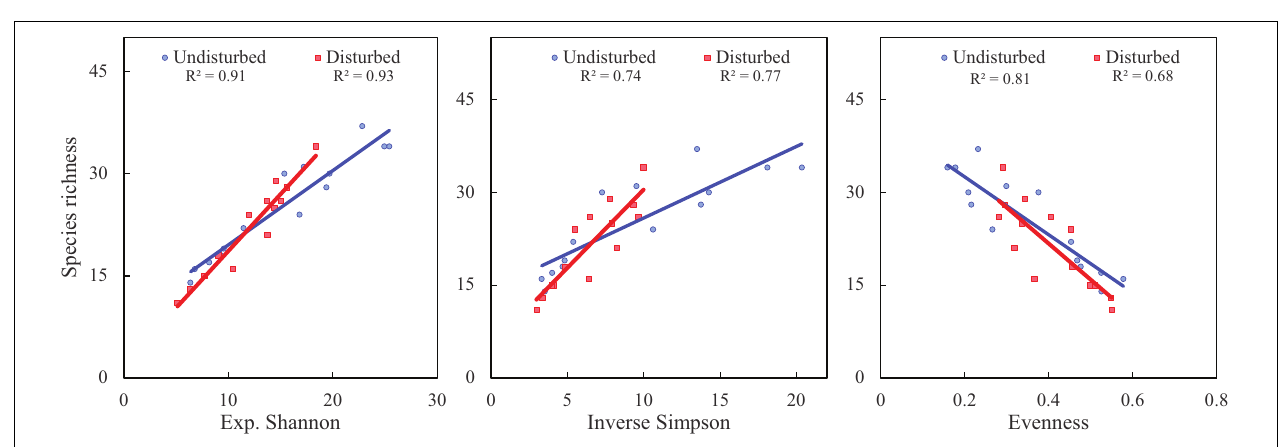
FIGURE 4 | Correlation analysis of species richness with diversity indices (as per Hill numbers) in disturbed and undisturbed sites in VoFNP. The linear fits and r 2 values (at a p -value < 0.05) are presented in boxes.